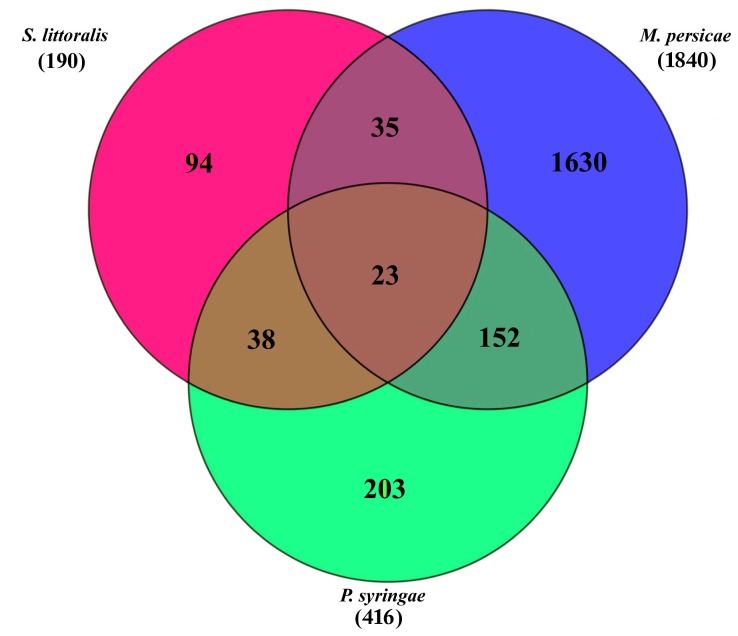
Venn diagram of commonly and differentially expressed Arabidopsis genes upon herbivory by Spodoptera littoralis and Myzus persicae and infection by Pseudomonas syringae.